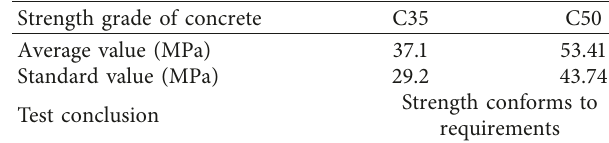
Table 2: Mechanical properties of steel bars. Table 3: Mechanical properties of